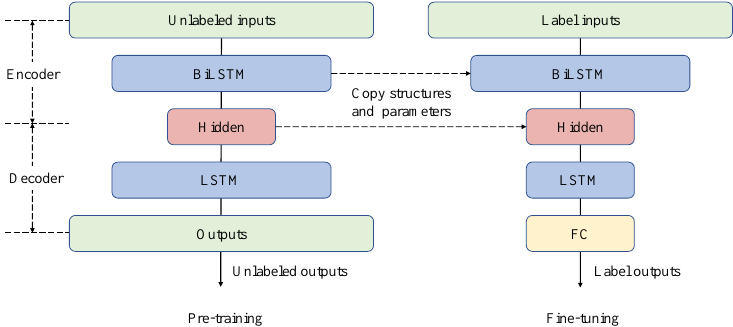
Figure 7. Brief flowchart of semi-supervised encoder-decoder model with pre-training and fine- tuning methods.